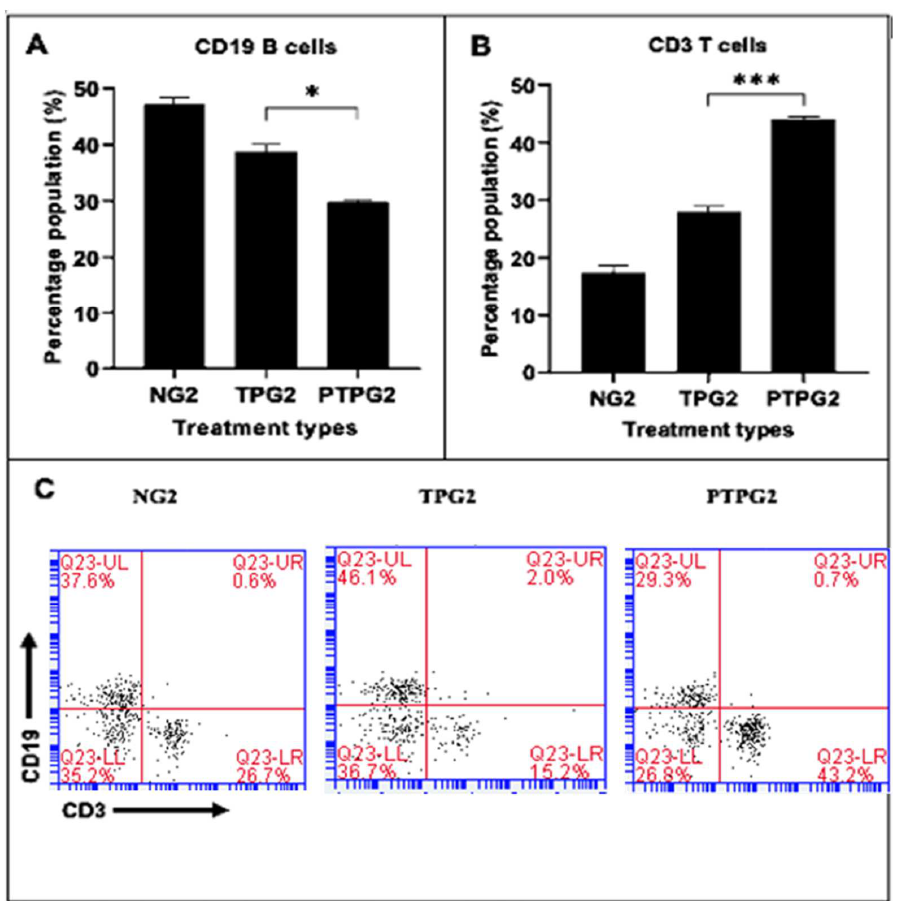
Figure 2. T-cells and B-cells populations following the different diet treatment types were measured by fluorescence-activated cell sorting (FACS) flow cytometry. The percentage of ( A ) B-cells and ( B ) T-cells populations were calculated as % of total CD19 + B cells and CD3 + T cells, respectively. ( C ) Representative flow cytometric dot plots showing T-cells (CD3 + ) and B-cells (CD19 + ) as calculated from the percentages of total live cells (50,000 events). Unfermented glutinous rice (NG) served as the control group. Both traditional Tapai Pulut (TPG) and probiotic Tapai Pulut (PTPG) showed a significant decrease in B-cells and an increase in T-cells populations. PTPG2 exhibited the most significant decrease in the percentage of CD19 + B-cells and an increase in the CD3 + T-cells populations compared with TPG2 against the NG2 control. Results are expressed as percentage of cells population (%) ± S.E.M. Asterisk over bars indicates the degree of significance as compared with the traditional Tapai Pulut (TPG) group; * p ≤ 0.005, and *** p ≤ 0.0001.